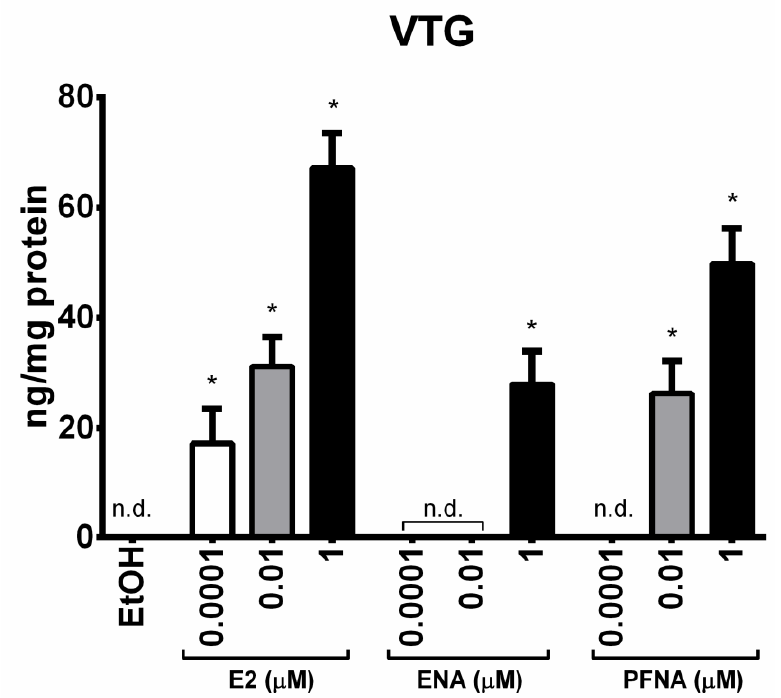
Figure 4. Changes in medium VTG levels in Mugil cephalus hepatocytes exposed to different con- centrations (0.0001–1 μM) of E2, ENA, PFNA for 48 h. n.d.: not detectable. “*” indicates significant differences between control and treated groups ( p < 0.05).